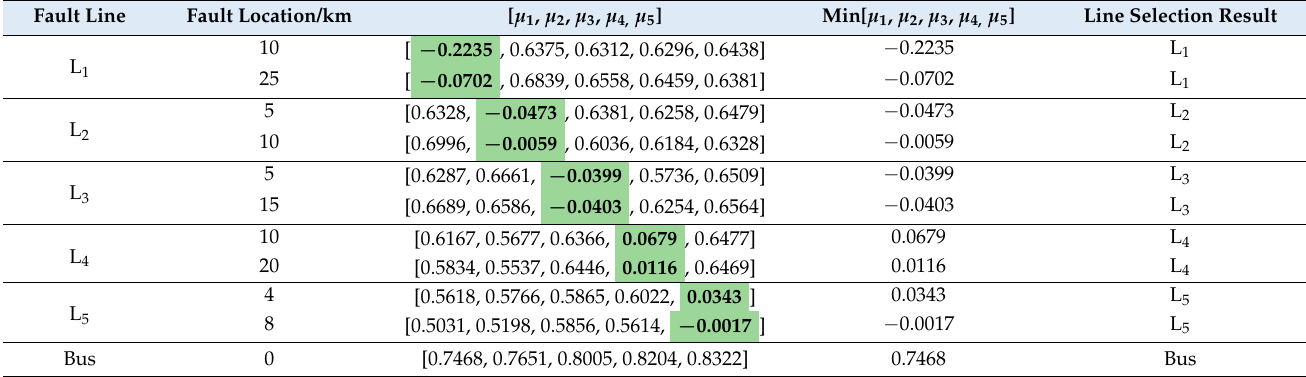
Table 3. The results of feeder identification when R d = 20 Ω and ϕ = π /4.